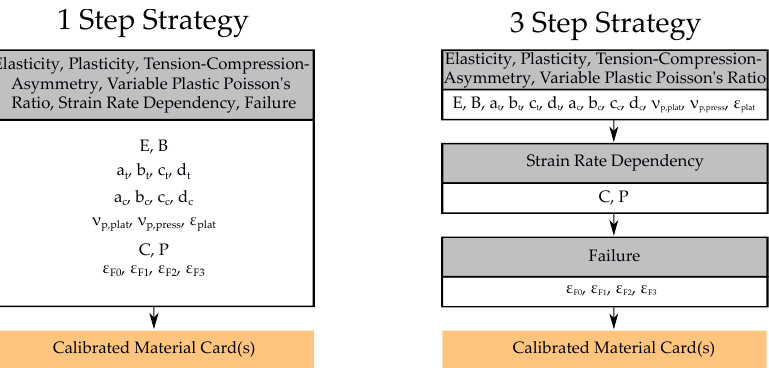
Figure 7. Used 1 Step Strategy and 3 Step Strategy for iterative optimization-based calibration.